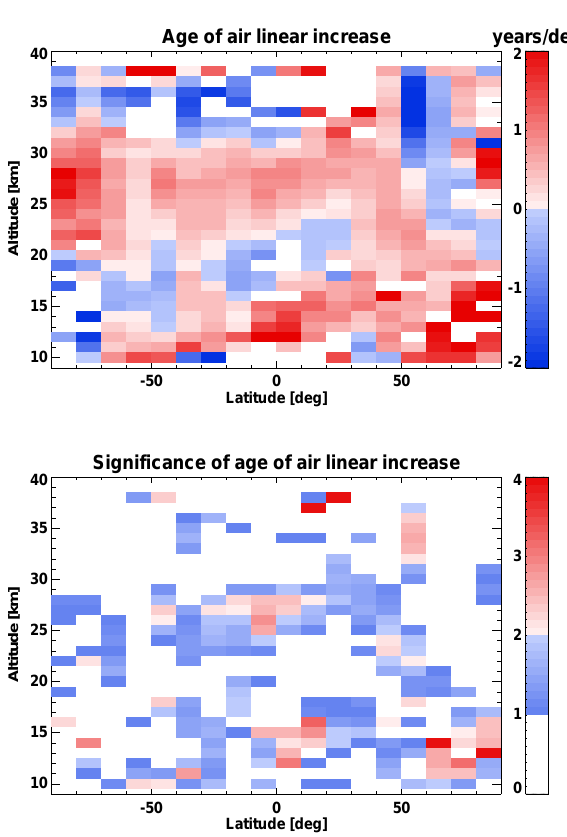
Fig. 12. Altitude-latitude cross-section of the AoA model-error corrected linear increase (top) and its significance in terms of mul- tiples of σ (bottom) after including the model error and autocorre- lations between the data points in the